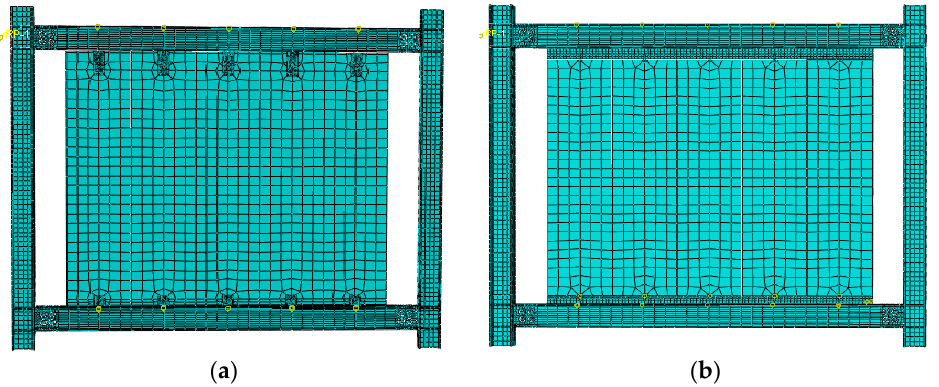
Figure 20. Finite element model with ( a ) FW-1 and ( b ) FW-2. Table 4. Material